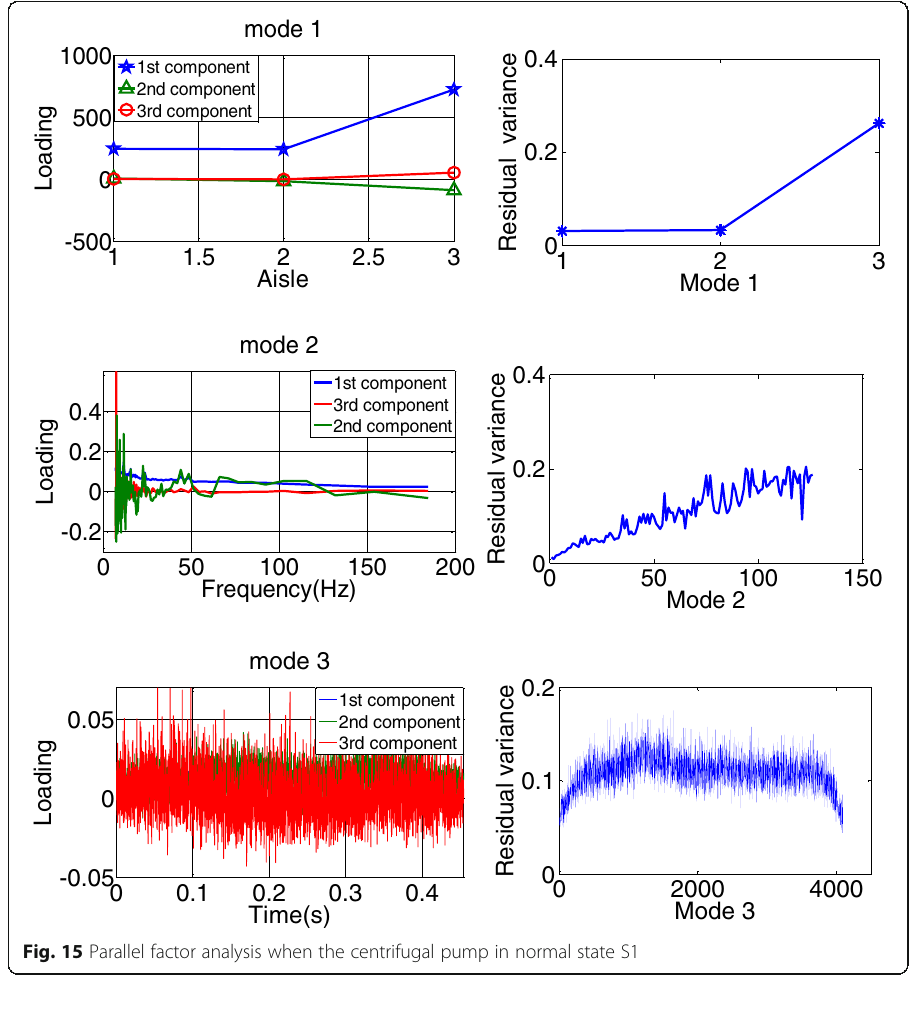
Fig. 15 Parallel factor analysis when the centrifugal pump in normal state S1